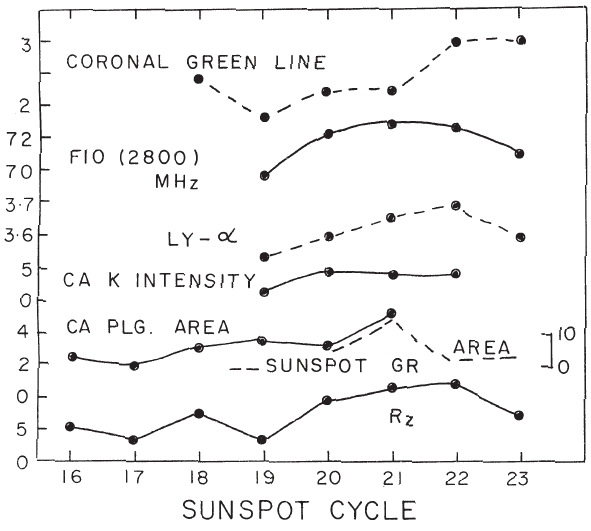
Fig. 12. Plots of the minima of some solar indices for cycles